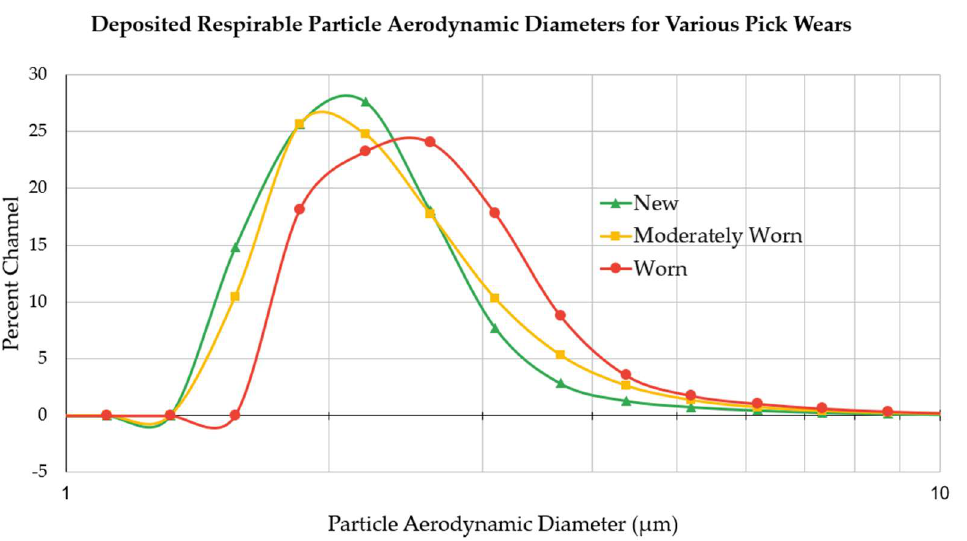
Figure 11. The particle size distribution of the deposited particles generated from the new, moderately worn, and fully worn pick determined from laser diffraction of particles collected from the surface of the rock block.